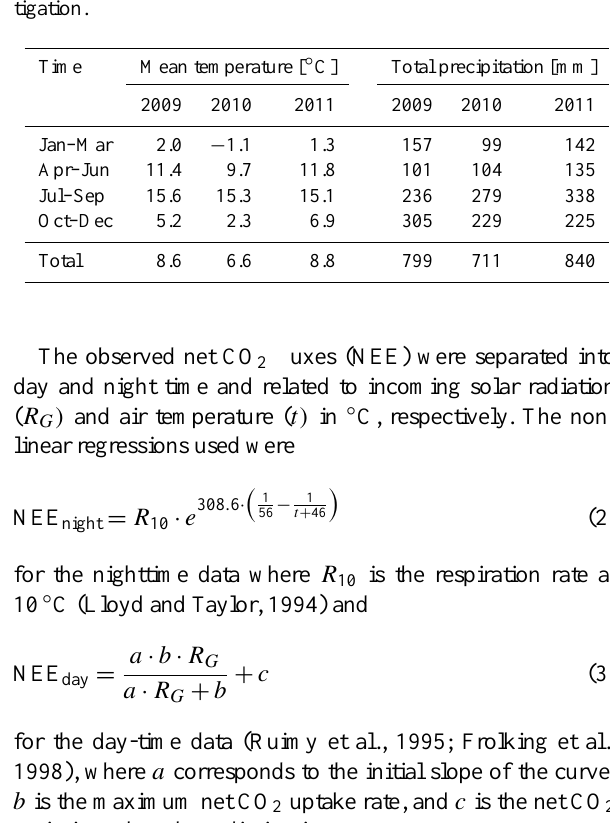
Table 1. Meteorological conditions during the 3 full years of inves- tigation.